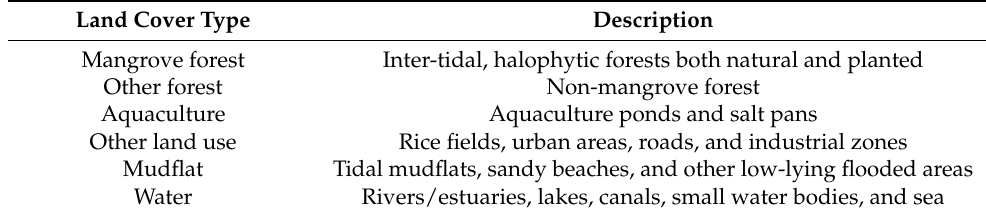
Table 2. Description of the land cover